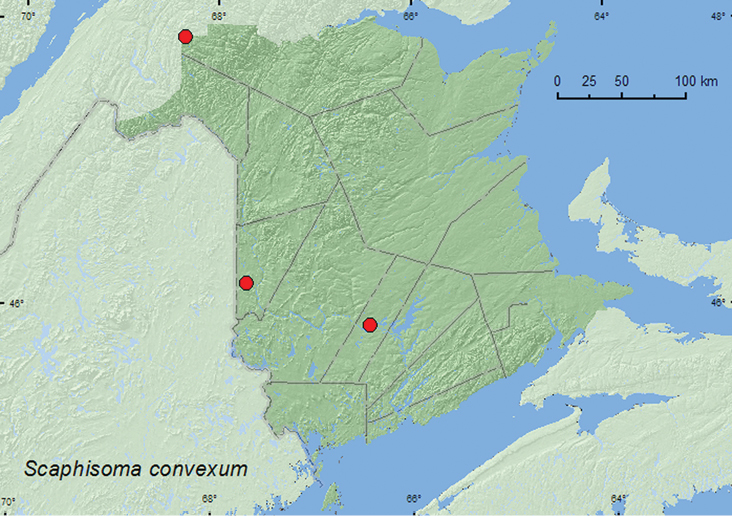
Collection localities in New Brunswick, Canada of Scaphisoma convexum.